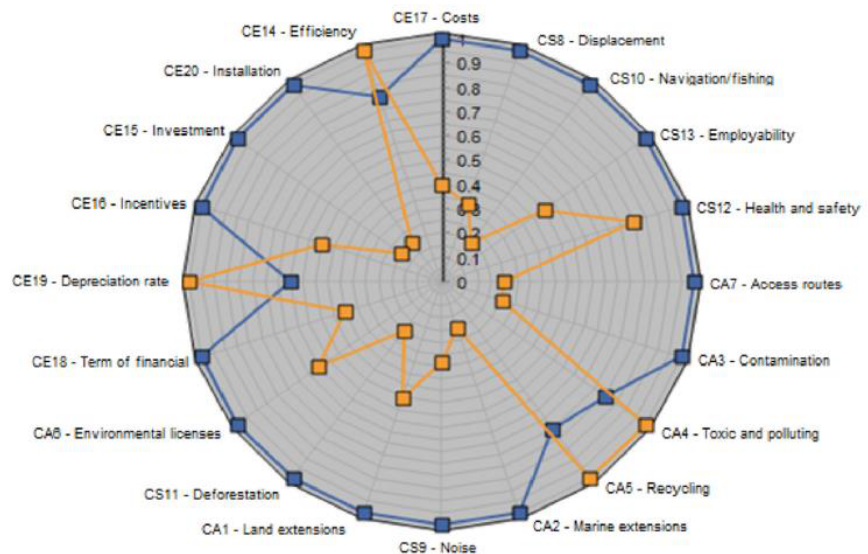
Figure 18. A radar chart with the 20 criteria, showing the predominance of photovoltaic over wave energy. Reprinted with permission from ref. [94]. Copyright © 2020 Elsevier Ltd. All rights reserved.